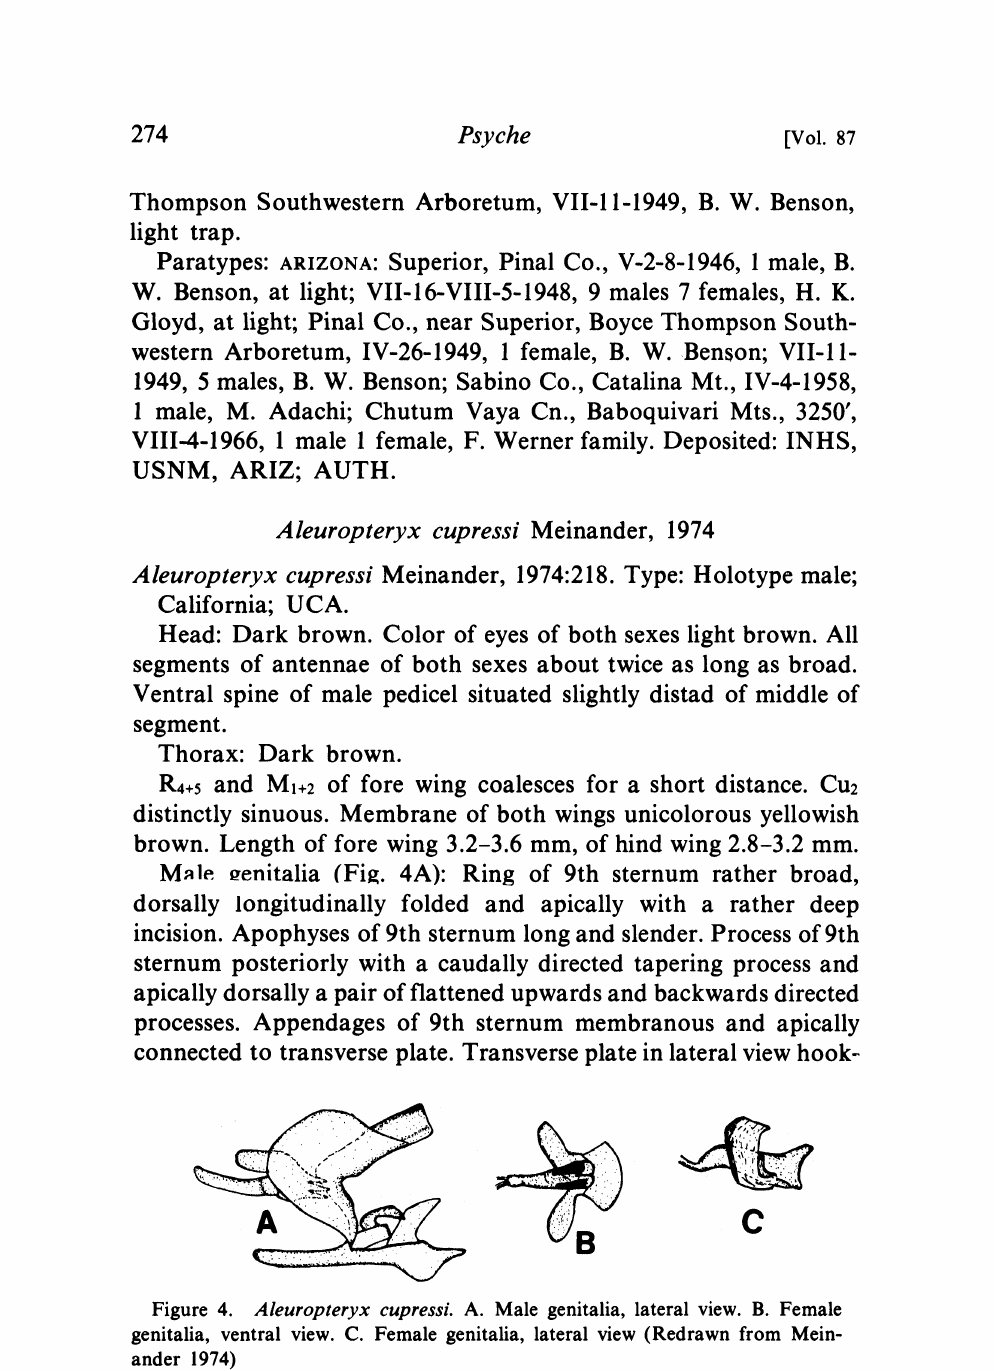
Figure 4. Aleuropteryx cupressi. A. Male genitalia, lateral view. B.